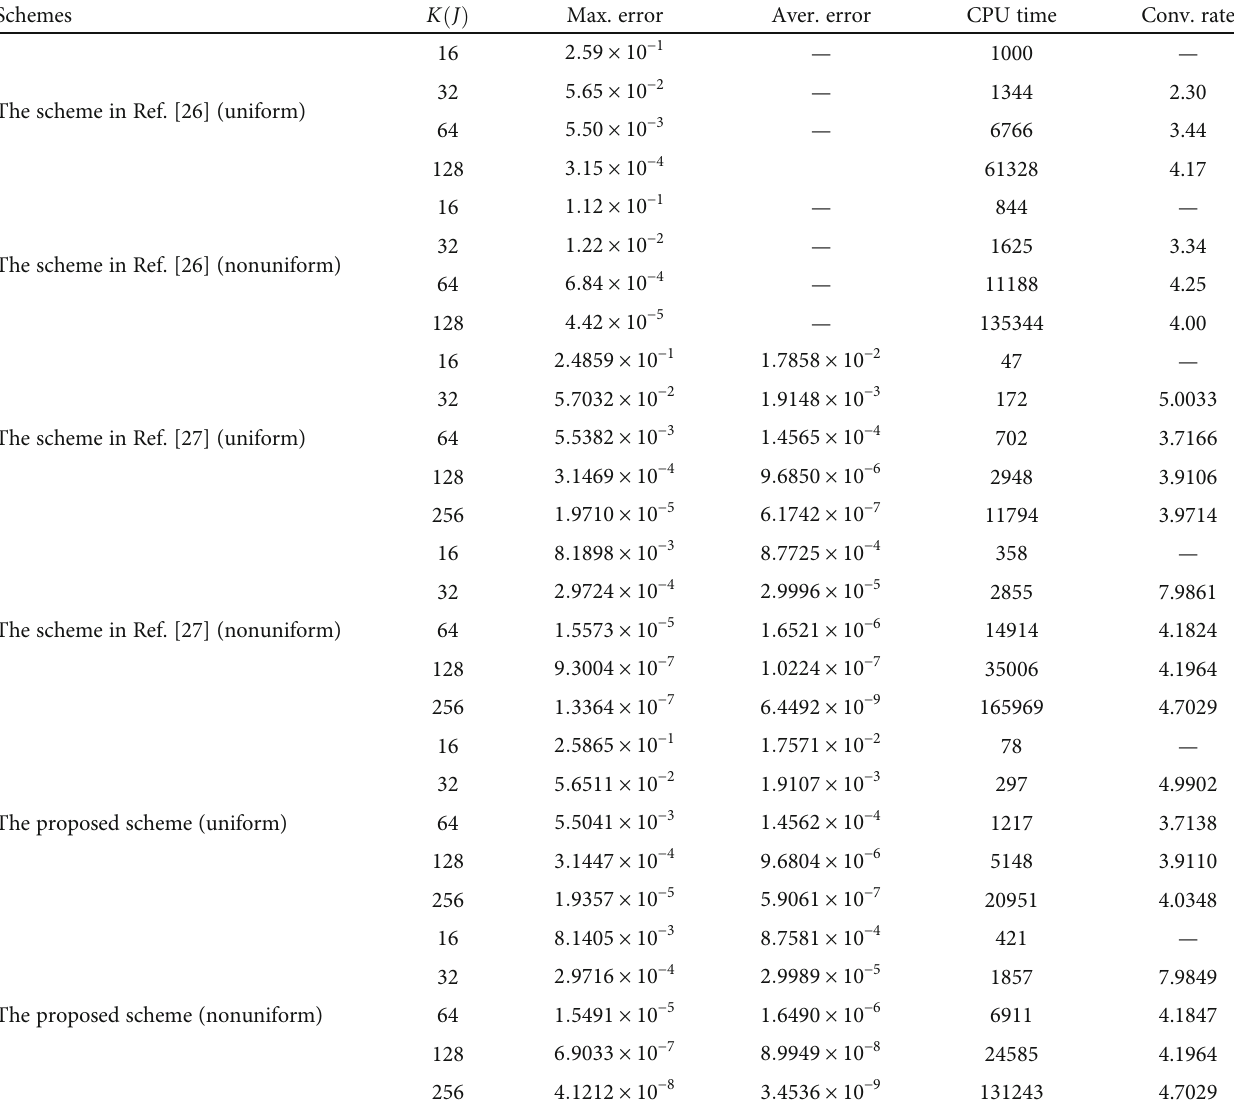
Table 1: The parameter values for common